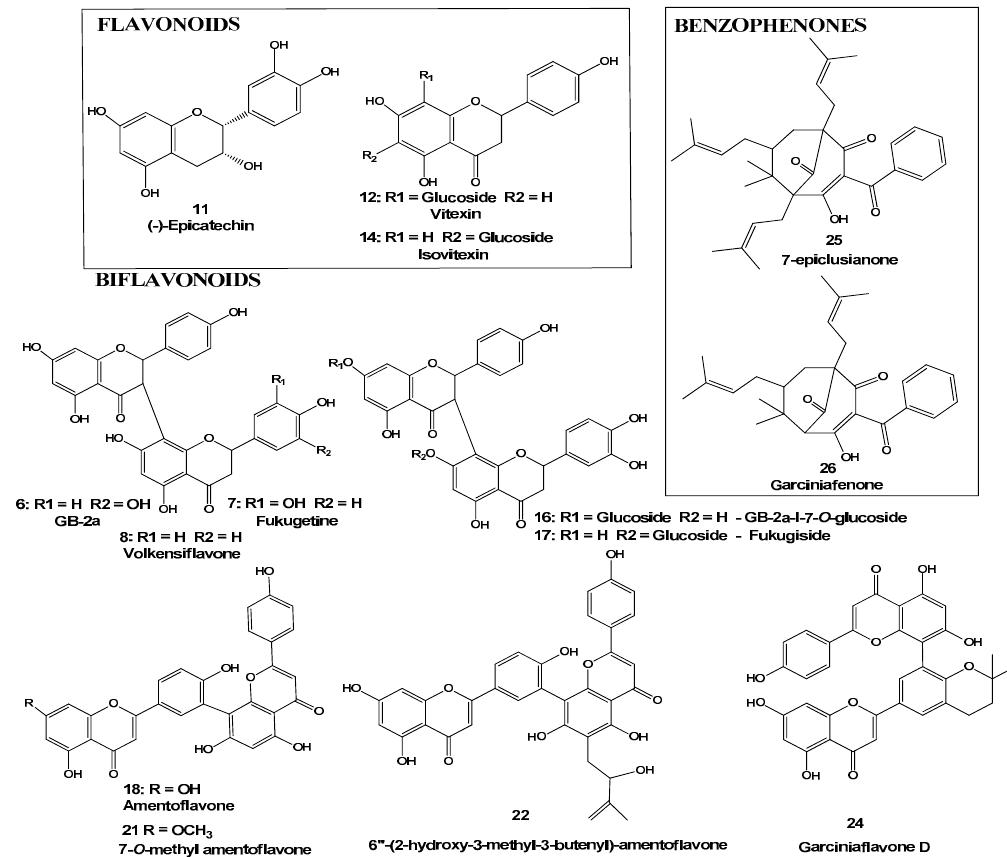
Figure 1. Compounds identified in the ethanol extracts of fruits (EEF) and leaves (EEL) of Garcinia gardneriana . The HPLC-DAD-MS analysis of EEF (ethanol fruits’ extract) and fractions resulted in the identification of the compounds listed in Table 1. Table 1. Compounds tentatively identified from the ethanol extract of Garcinia gardneriana fruits (EEF).